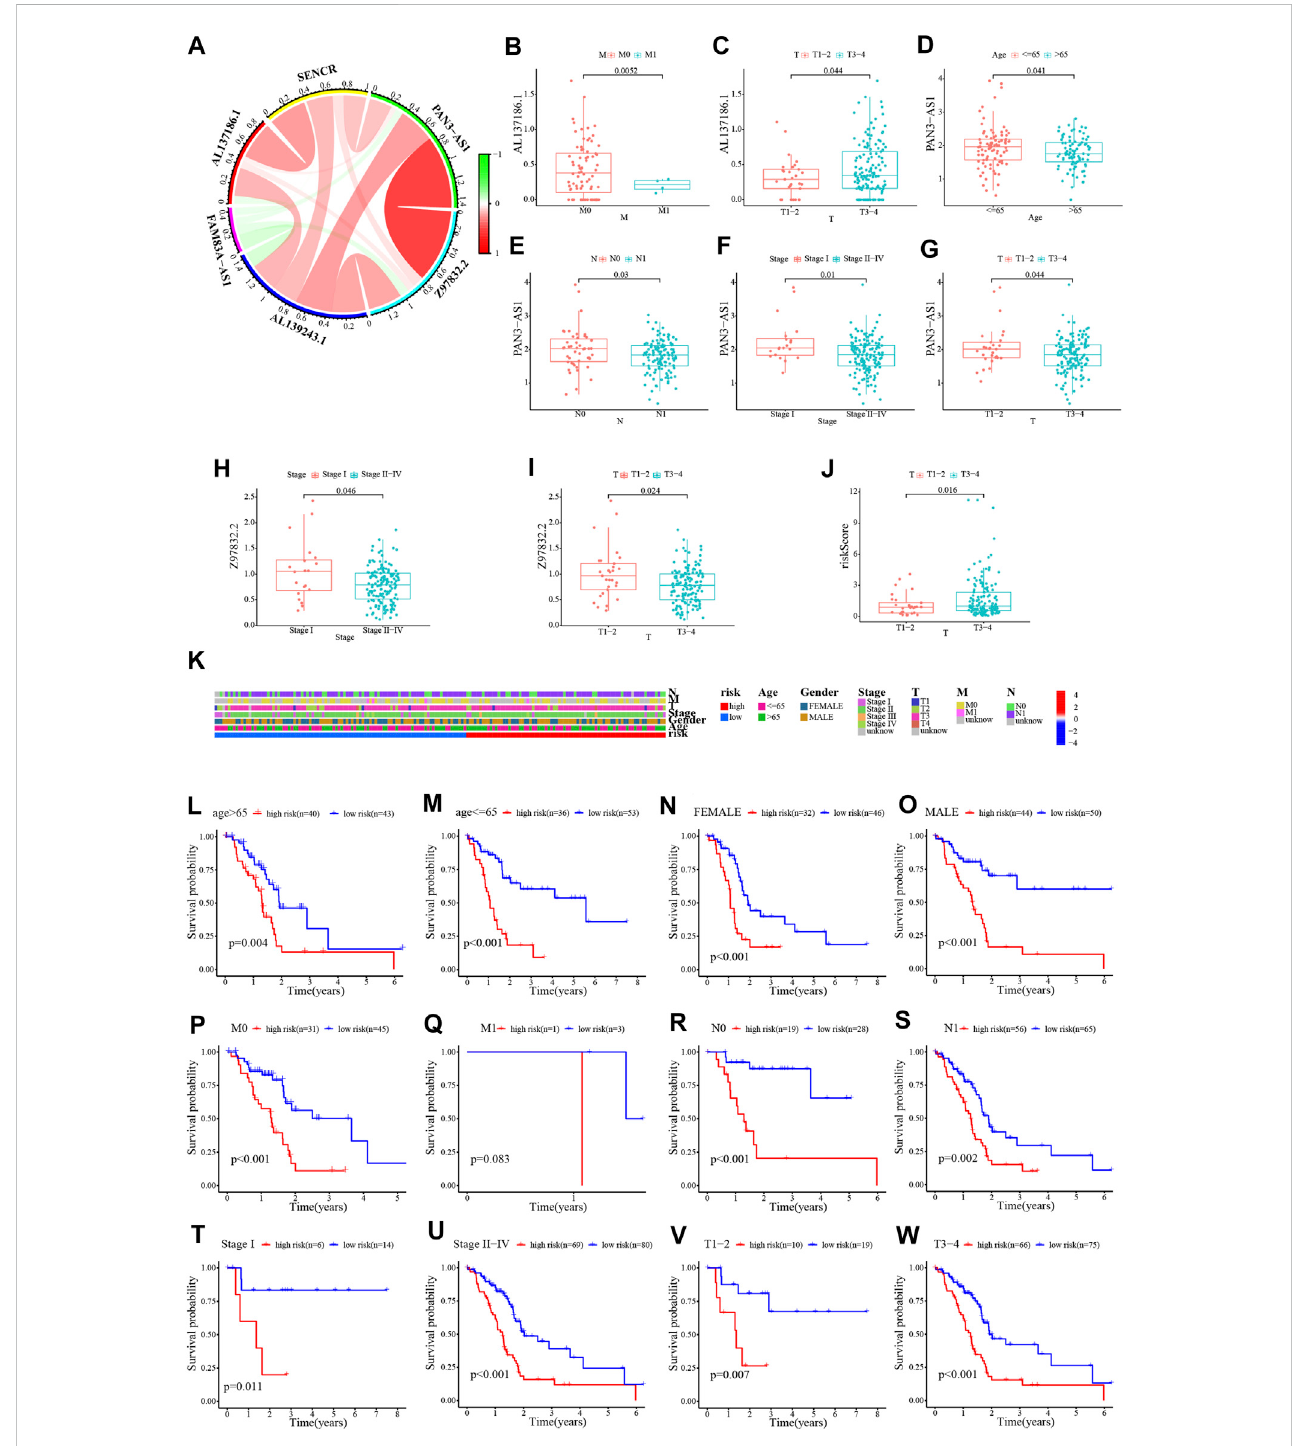
FIGURE 6 Relationship between risk score and clinical characteristics. (A) Chord diagram of the relationship between the six signature CRLncs. (B – J) The relationshipbetweenthesesignatureCRLncsandriskscorewithclinicalfeatures. (K) The clinicalcharacteristicsheatmap. (L – W) The survivalofPCpatientsin different risk group across clinical characteristic